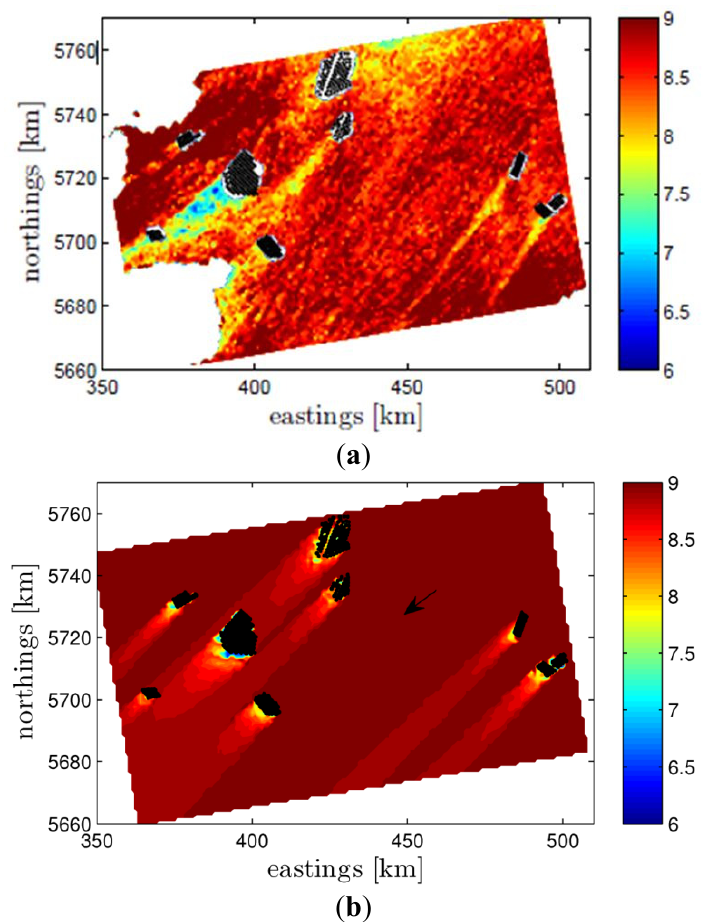
Figure 2. ( a ) Satellite 10-m SAR wind retrieval observed 30 April 2013 at 17:41 UTC and ( b ) modified PARK wake results at 70 m for the wind farms in the UK and Belgium. The wind direction used for the modeling is indicated with the black